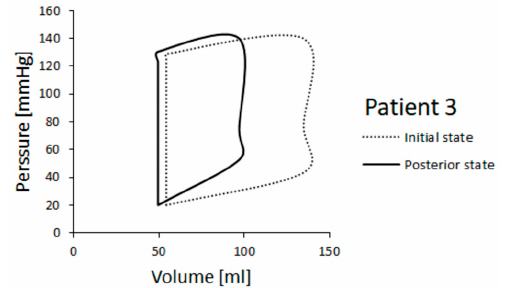
Figure 12. P-V diagram for patient 3.